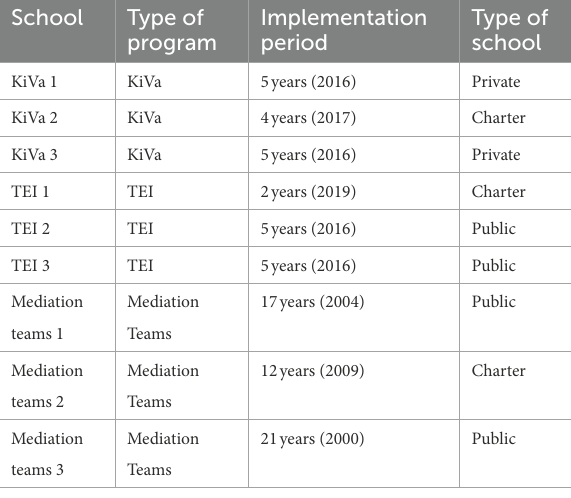
TABLE 2 Schools participating in the